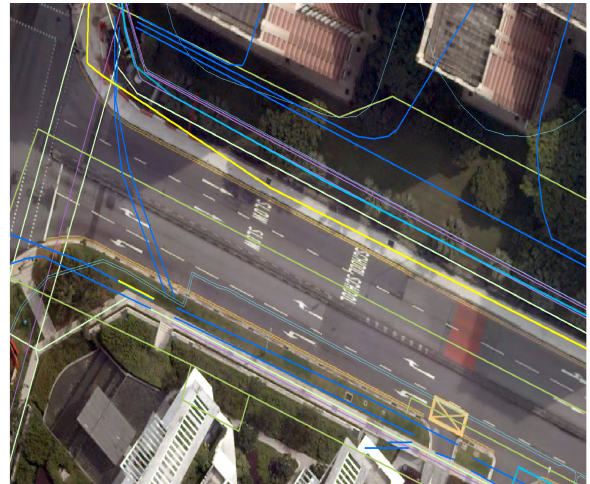
Figure 3. Available map data on existing utilities in highlighted area, Toa Payoh.